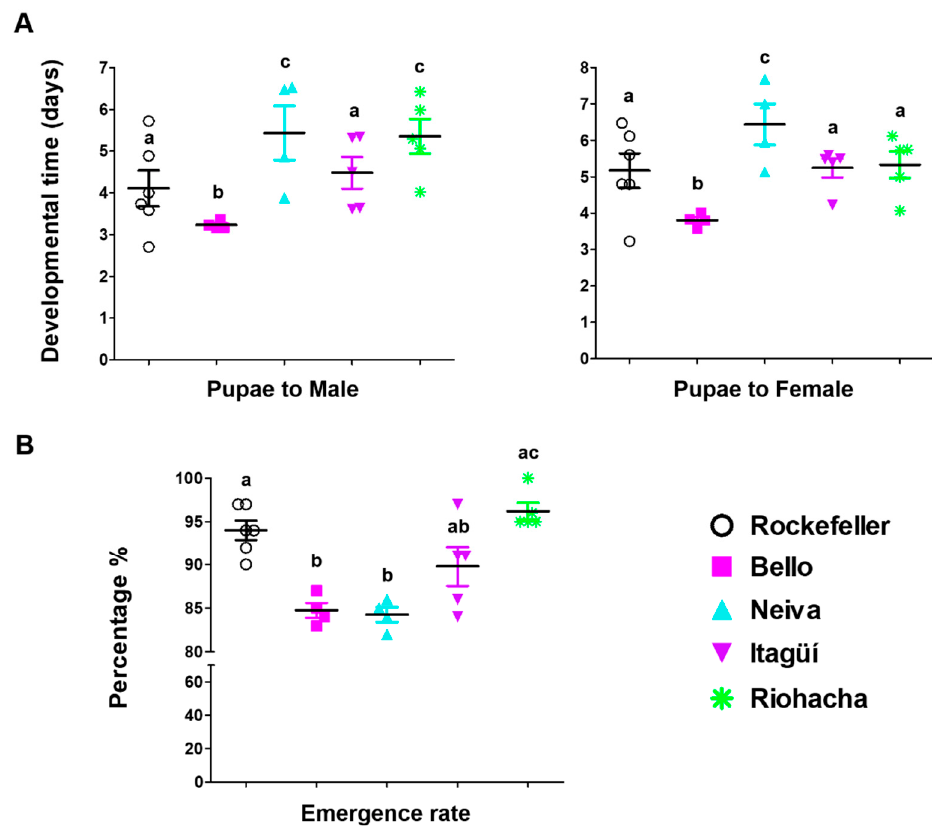
Figure 3. ( A ) Emergence time (days to develop from pupae to adult male or female) and ( B ) emer- gence rate of Colombian Ae. aegypti populations reared at 28 ± 1 °C temperature, 80 ± 5% relative humidity, and 12 h light: 12 h dark photoperiod. The mean and standard error of the mean were plotted. Each point represents a replicate from a cohort of 100 eggs. The total number of replicates were: Bello and Neiva (4); Itagüí and Riohacha (5), and control Rockefeller (6). A one-way analysis of variance (ANOVA) was conducted, followed by a Bonferroni post-hoc test to account for multiple comparisons between Ae. aegypti populations. Populations sharing the same letters are not significantly different ( p > 0.05).